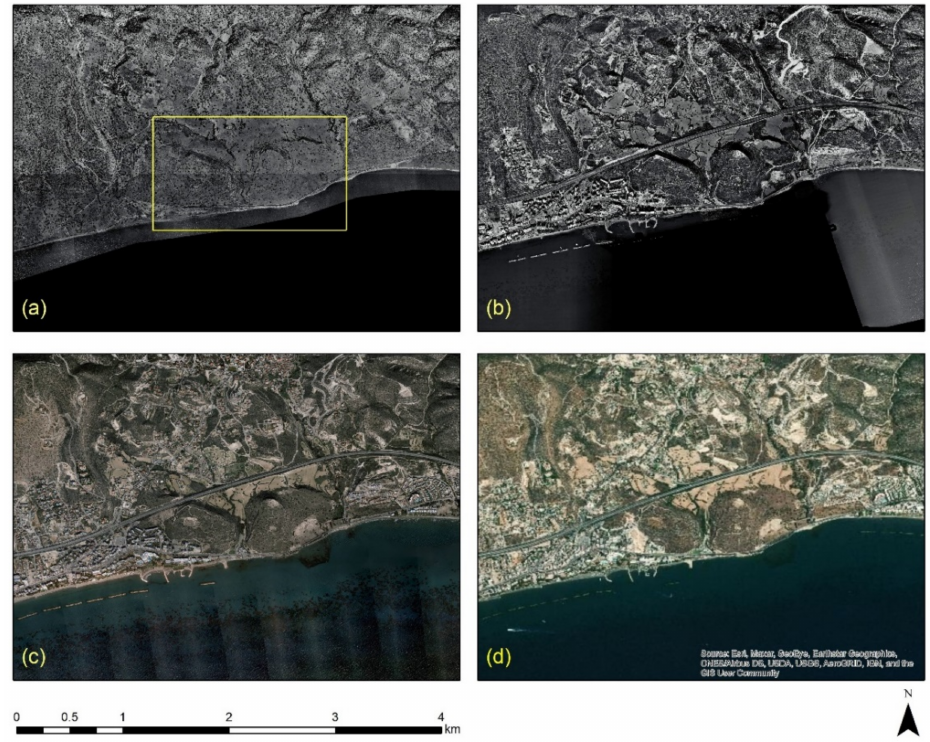
Figure 2. A diachronic overview of Limassol city, Cyprus, using archive aerial and satellite images. The archaeological site of Amathus is shown with a yellow rectangle: ( a ) orthophoto image of 1963; ( b ) orthophoto image of 1993; ( c ) orthophoto image of 2014; and ( d ) a recent satellite image from ArcGIS online database (source of aerial orthophotos: Department of Land and